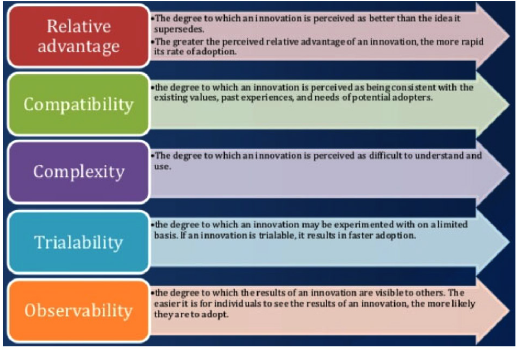
Figure 1. The DOI theory framework ( source: Rogers, 2003)